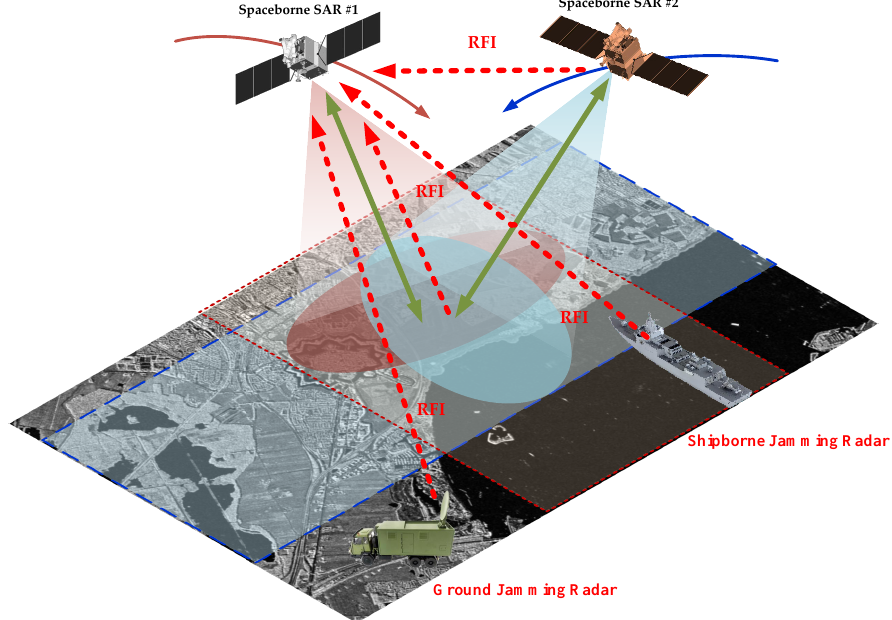
Figure 1. Geometric interpretation of interference to Spaceborne